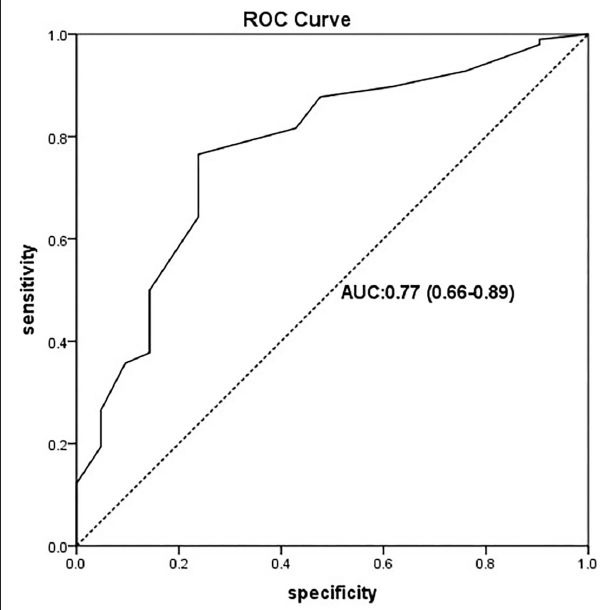
FIGURE 1 | ROC curve of the predictive model for the first-attempt success of radial artery catheterization (RAC) by the arterial depth. ROC curve with an AUC value of 0.77 (95% CI: 0.66–0.89). ROC, receiver-operating characteristic ROC; AUC, area under the ROC